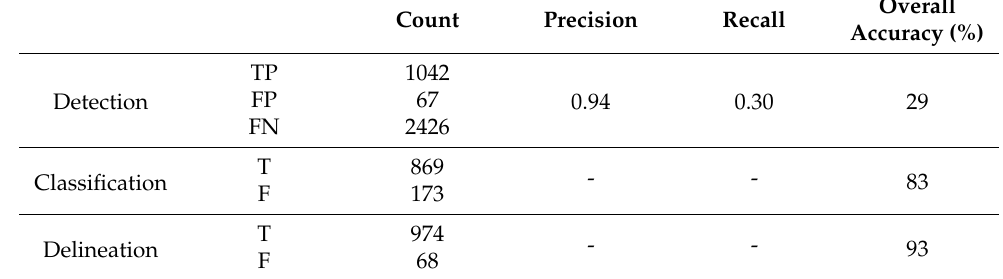
Table 5. Accuracy assessment for original images (3.0 m).